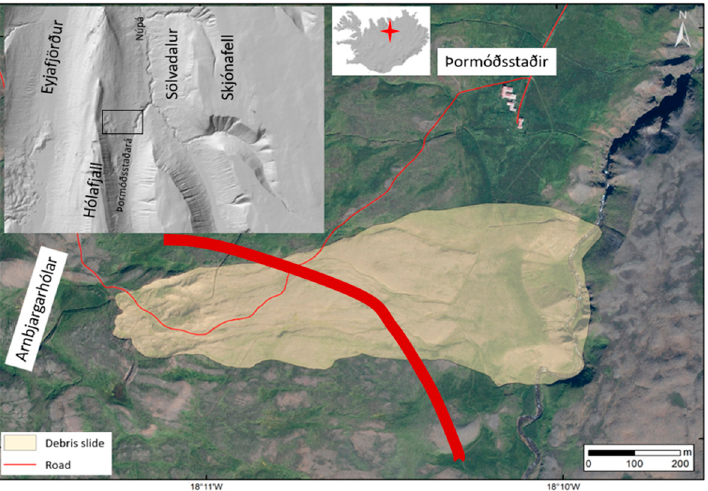
Figure 4. Overview map of the Sölvadalur landslide. Location in the valley in north Iceland in upper left corner. Location in Iceland shown. The landslide falls close to the farm Þormóðsstaðir, the inserted blue line shows the hypothethical position of a retaining protection wall that would have deflected the slide (aerial photo from Loftmyndir 2018, National Land Survey, Iceland DEM).